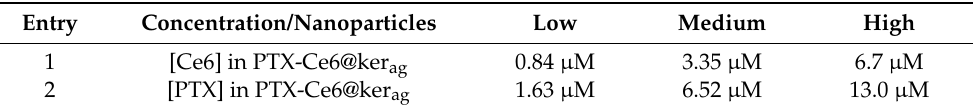
Table 1. Values of the three different concentrations of PTX-Ce6@ker ag nanoparticles, defined as Entry Concentration/Nanoparticles Low Medium